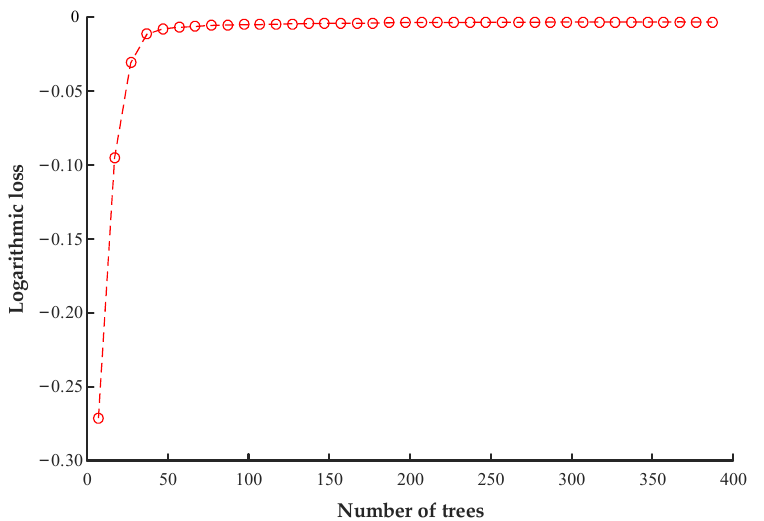
Figure 12. The parameters selection of the model.